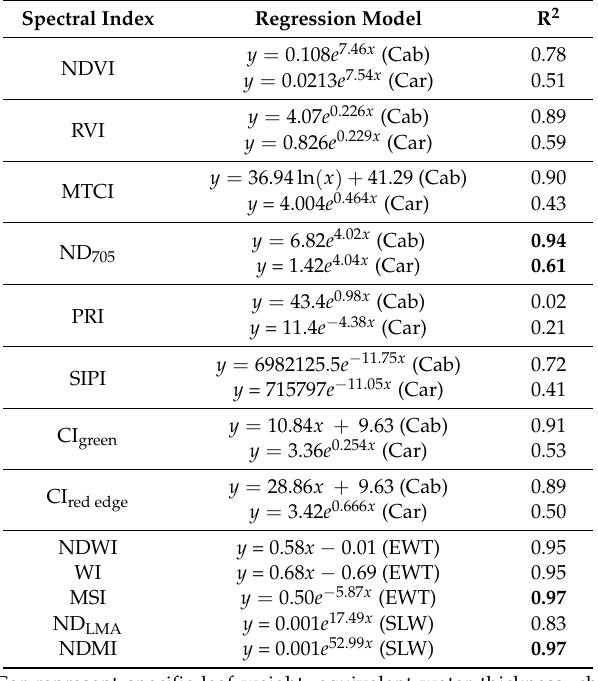
Table 5. The vegetation index (VI)-based models of leaf biochemical contents.